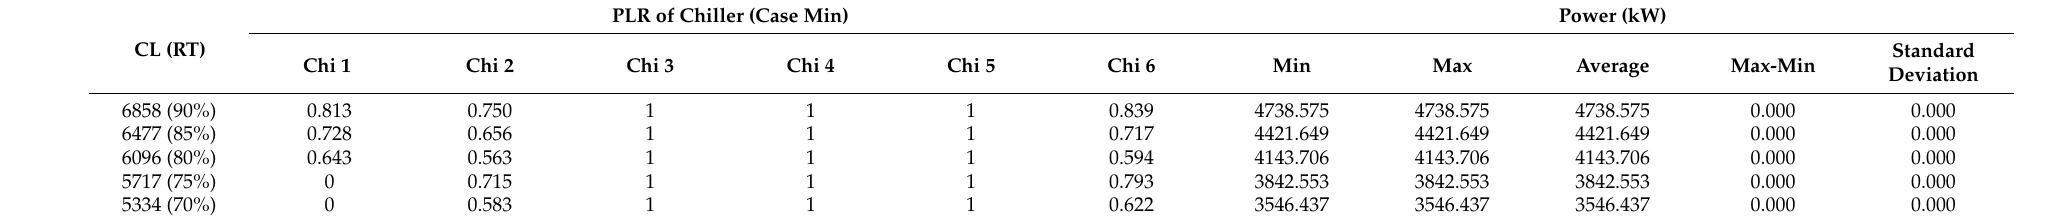
Table 9. Power Consumption of chillers in case 1 operated by TPSO